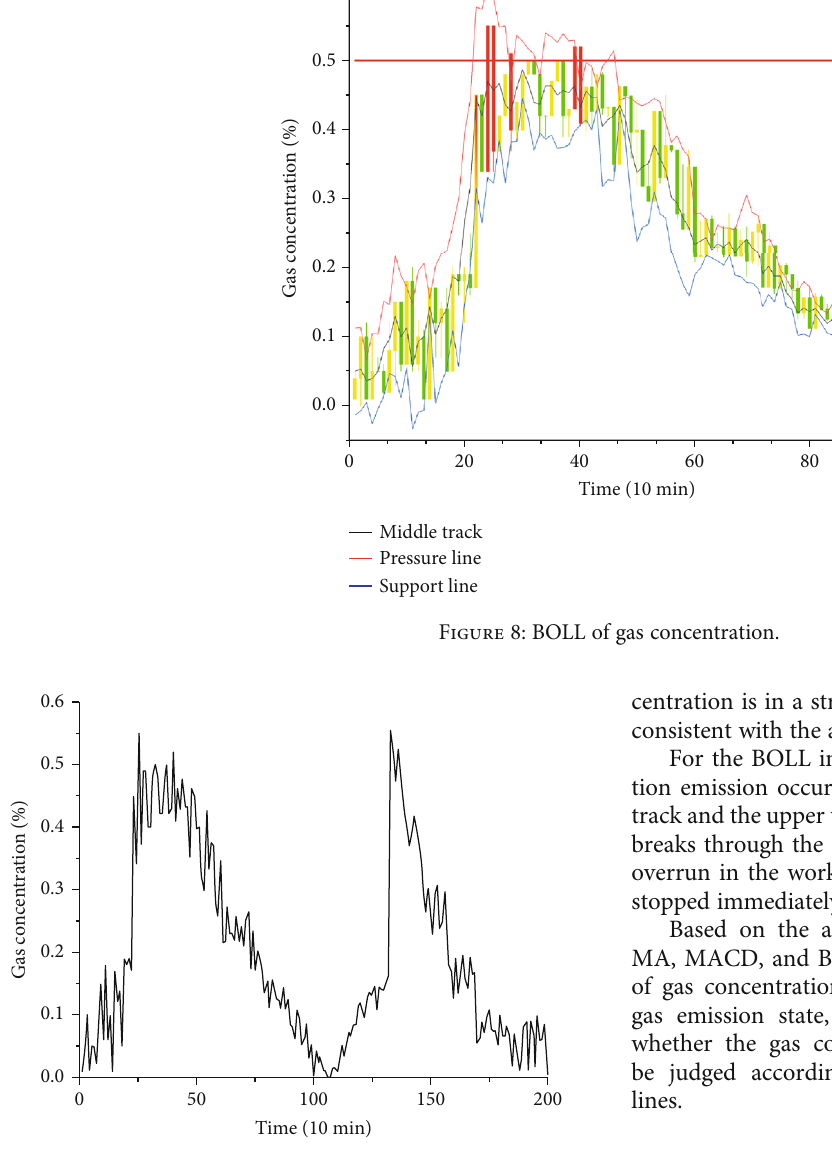
Figure 9: Time series